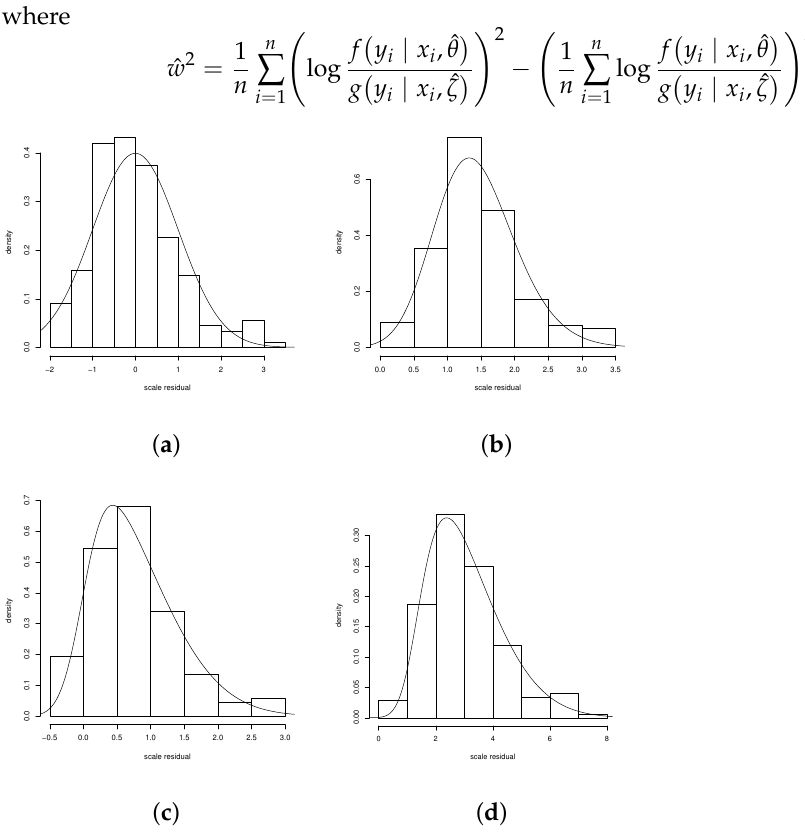
Figure 2. Histogram for scaled residuals for ( a ) Normal model, ( b ) PN model, ( c ) SN model, and ( d ) LGN model fitted to the cholesterol data.